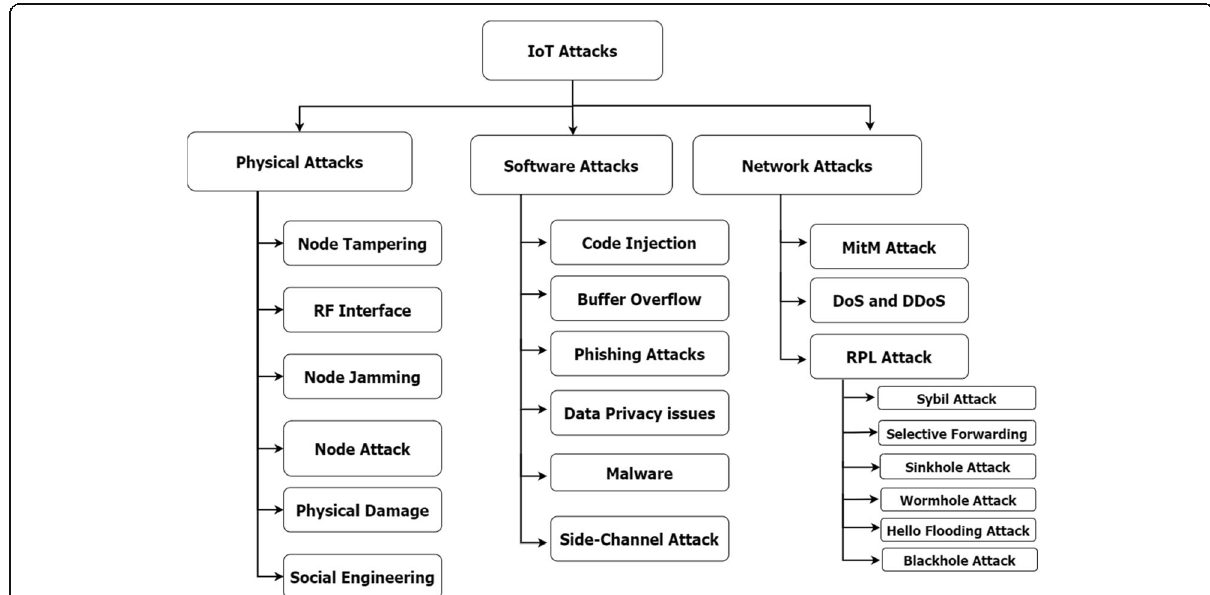
Fig. 9 Taxonomy of Security attacks within